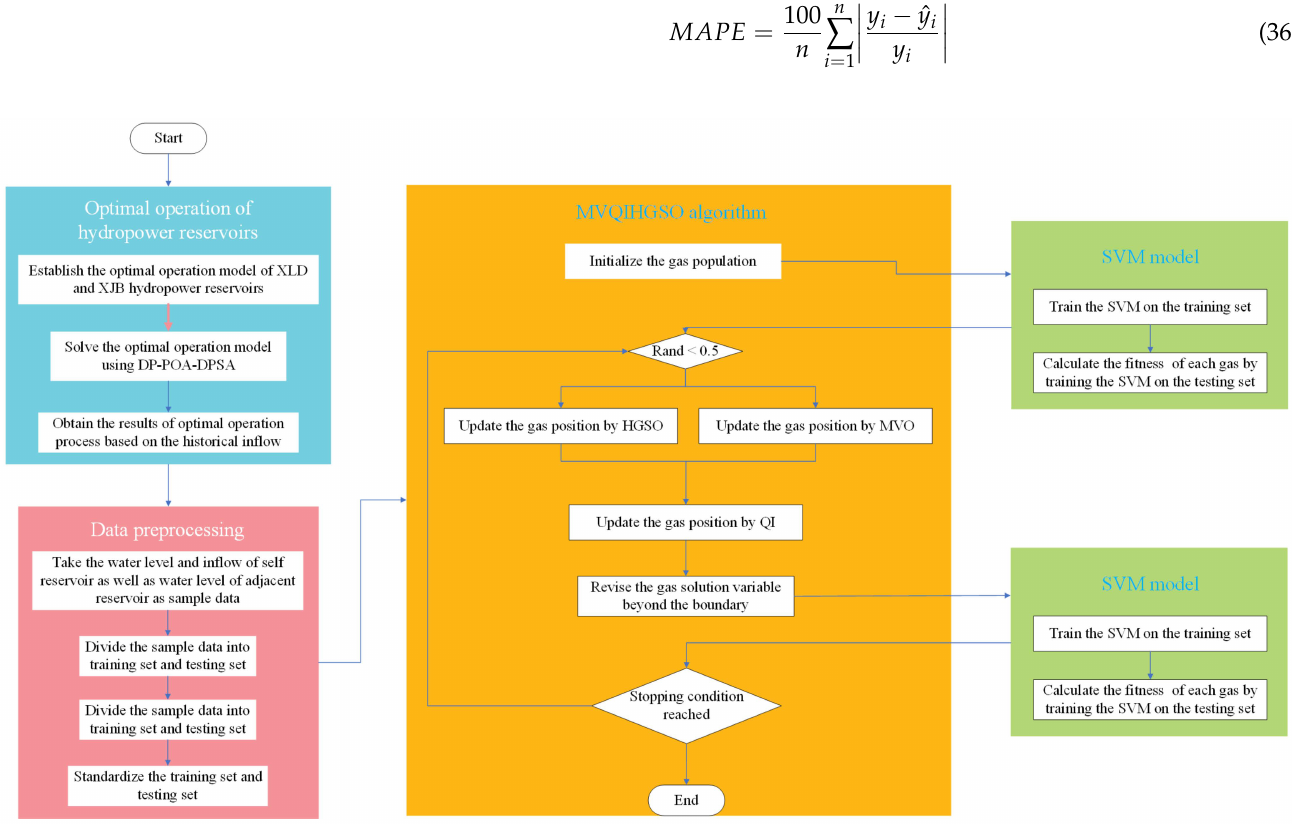
Figure 1. Flowchart of MVQIHGSO-SVM